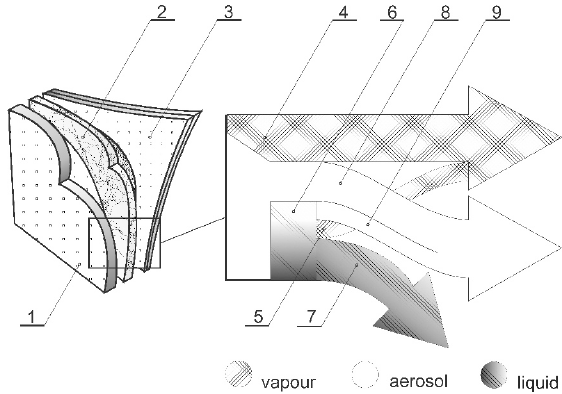
Figure 4. Moisture distribution in the FFR during its use (1—inner layer, 2—filtering layer, 3—outer layers, 4—vapor penetration, 5—evaporation, 6—collected water, 7—drained water, 8—penetration of droplets, 9—re-entrainment). Adapted from Raynor and Leith [47].